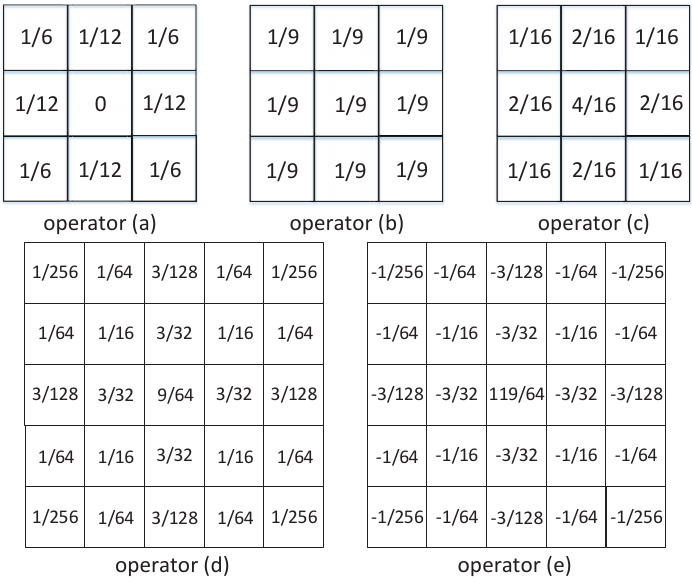
Figure 11. The convolution operator used in the weighted average filter. ( a ) SRMC operator [2]. ( b ) median filter operator. ( c ) 3 × 3 gaussian filter operator. ( d ) 5 × 5 gaussian filter operator. ( e ) image sharpening operator.